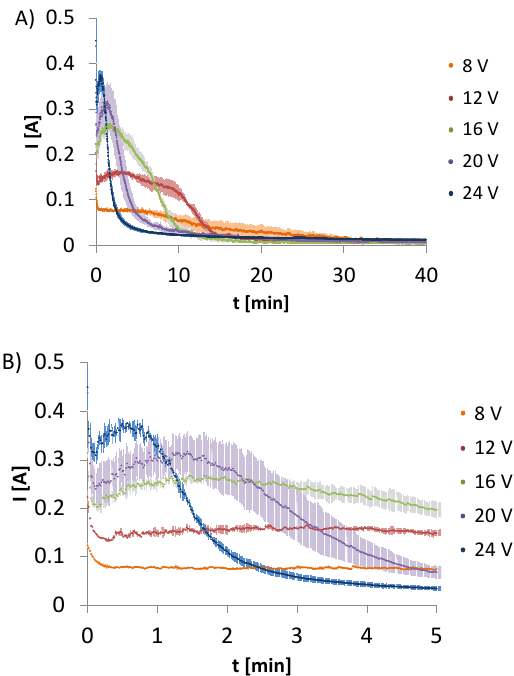
Figure 2. Amperage changes over ( A ) 40 min and ( B ) 5 min for electrodeposition from chitosan-hydroxyapatite colloidal solution initiated at different voltages. Data are shown as a mean ± standard deviation (n = 3).